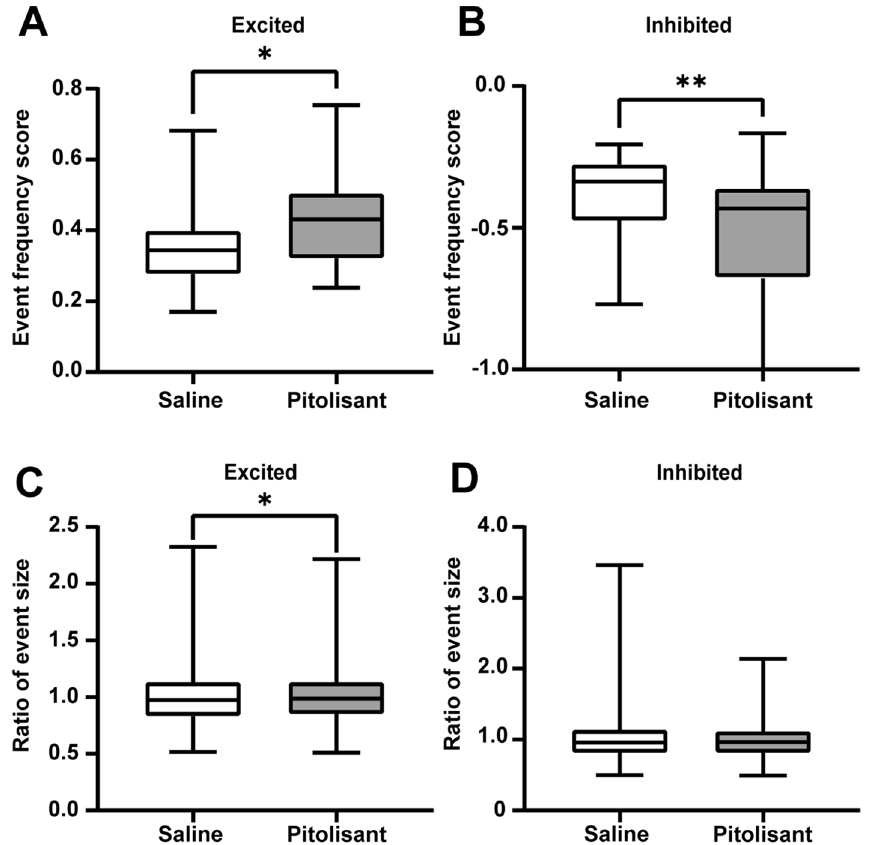
Figure 3. Calcium event frequency from excitatory and inhibitory responsive neurons differ between saline and pitolisant treatments. ( A ) The event frequency score of excitatory responsive neurons to pitolisant treatment is higher compared with saline treatment (* p = 0.029, Mann–Whitney U test). ( B ) The event frequency score of inhibitory responsive neurons to pitolisant treatment is lower compared with saline treatment (** p = 0.0030, Mann–Whitney U test). ( C ) The size of calcium events following pitolisant treatment is larger compared with saline treatment (* p = 0.021, Mann–Whitney U test). ( D ) The size of calcium events from inhibitory responsive neurons is comparable between saline and pitolisant